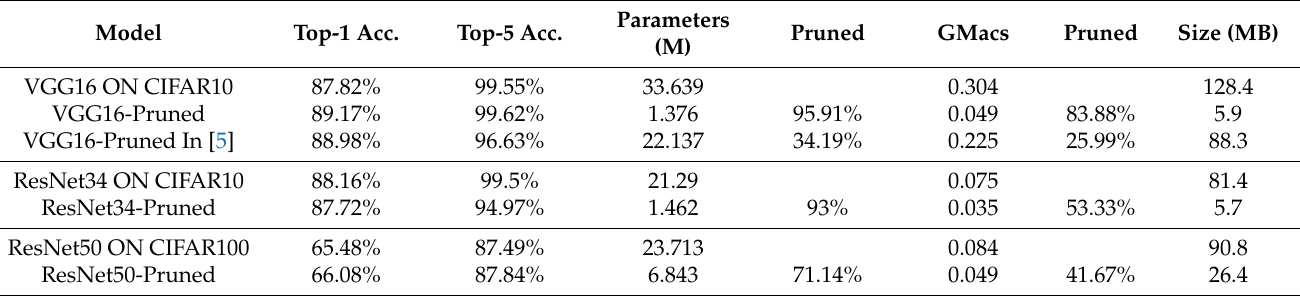
Table 2. Parallel the pruning results of different